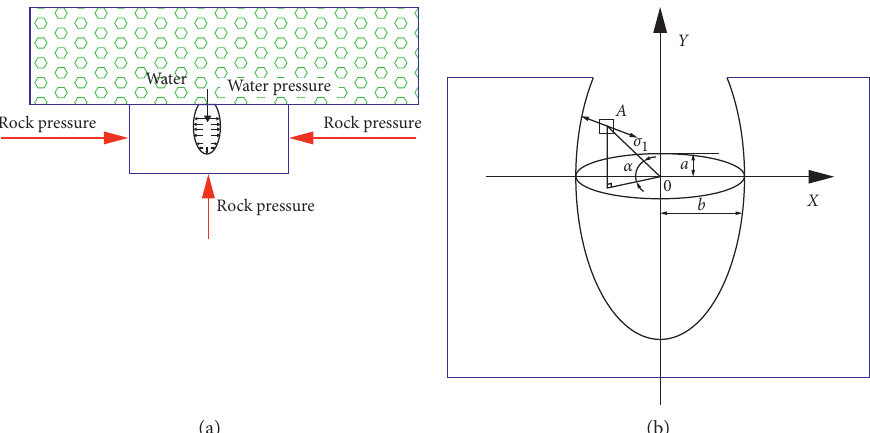
Figure 2: Schematic diagram of internal water pressure and external stress on fissure. (a) Schematic diagram of external stress on fissure. (b) Enlarged diagram of internal stress on fissure.